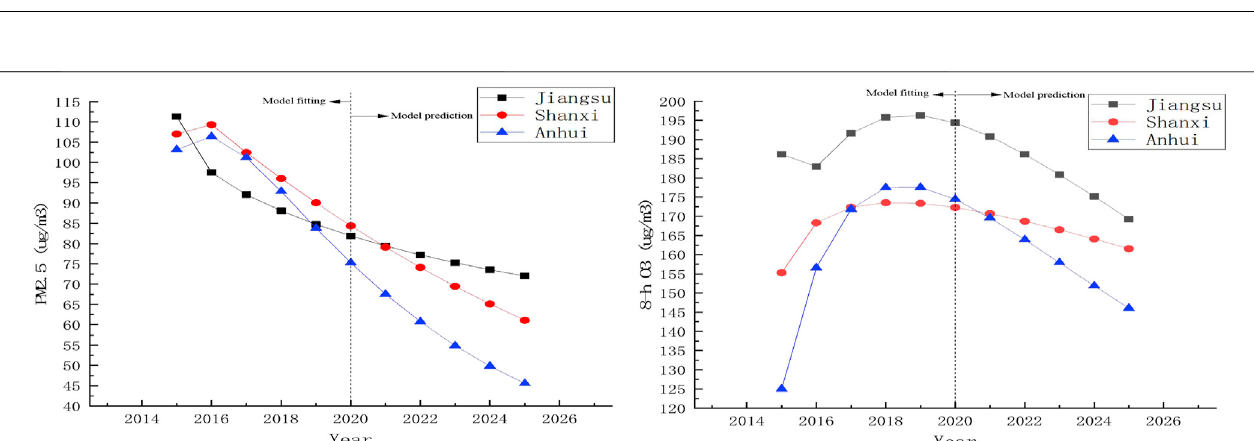
FIGURE 4 | Trends of annual average concentrations of PM 2.5 and 8-h O 3 in the three southern provinces.